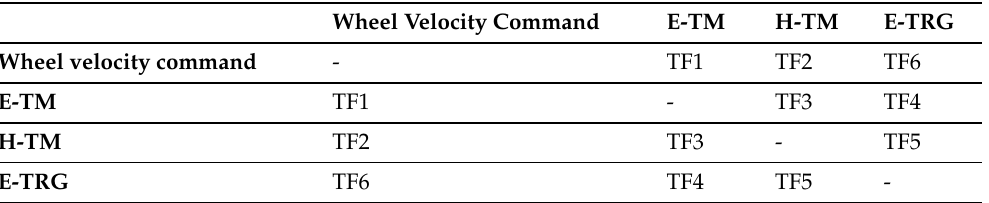
Table 2 recaps how the traction flags (TFs) are mapped to generate mitigation triggers. Table 2. Flag-failure